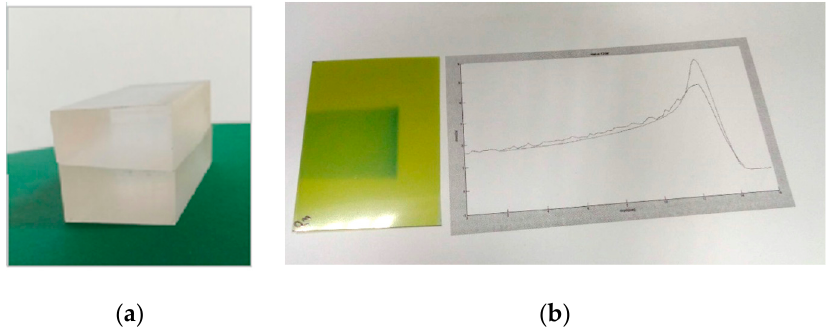
Figure 11. ( a ) PMMA phantom used to fix the radiochromic film (RCF) for longitudinal dose distributions; ( b ) An example of RFC irradiated with conventionally accelerated 62 MeV proton beams using the mentioned phantom, where it is clearly visible the increasing of darkness (and consequently, of dose) in proximity of the beam range.